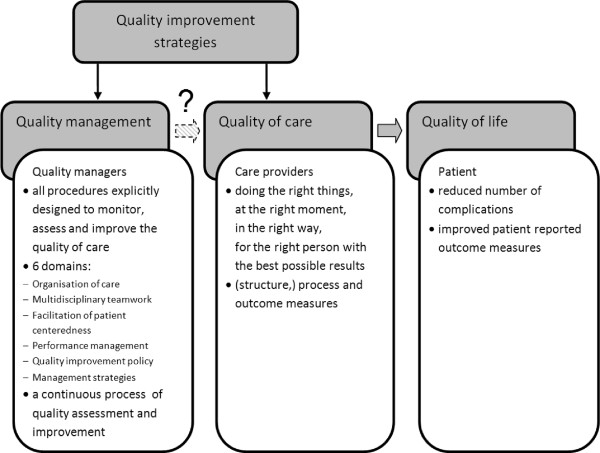
Quality management.